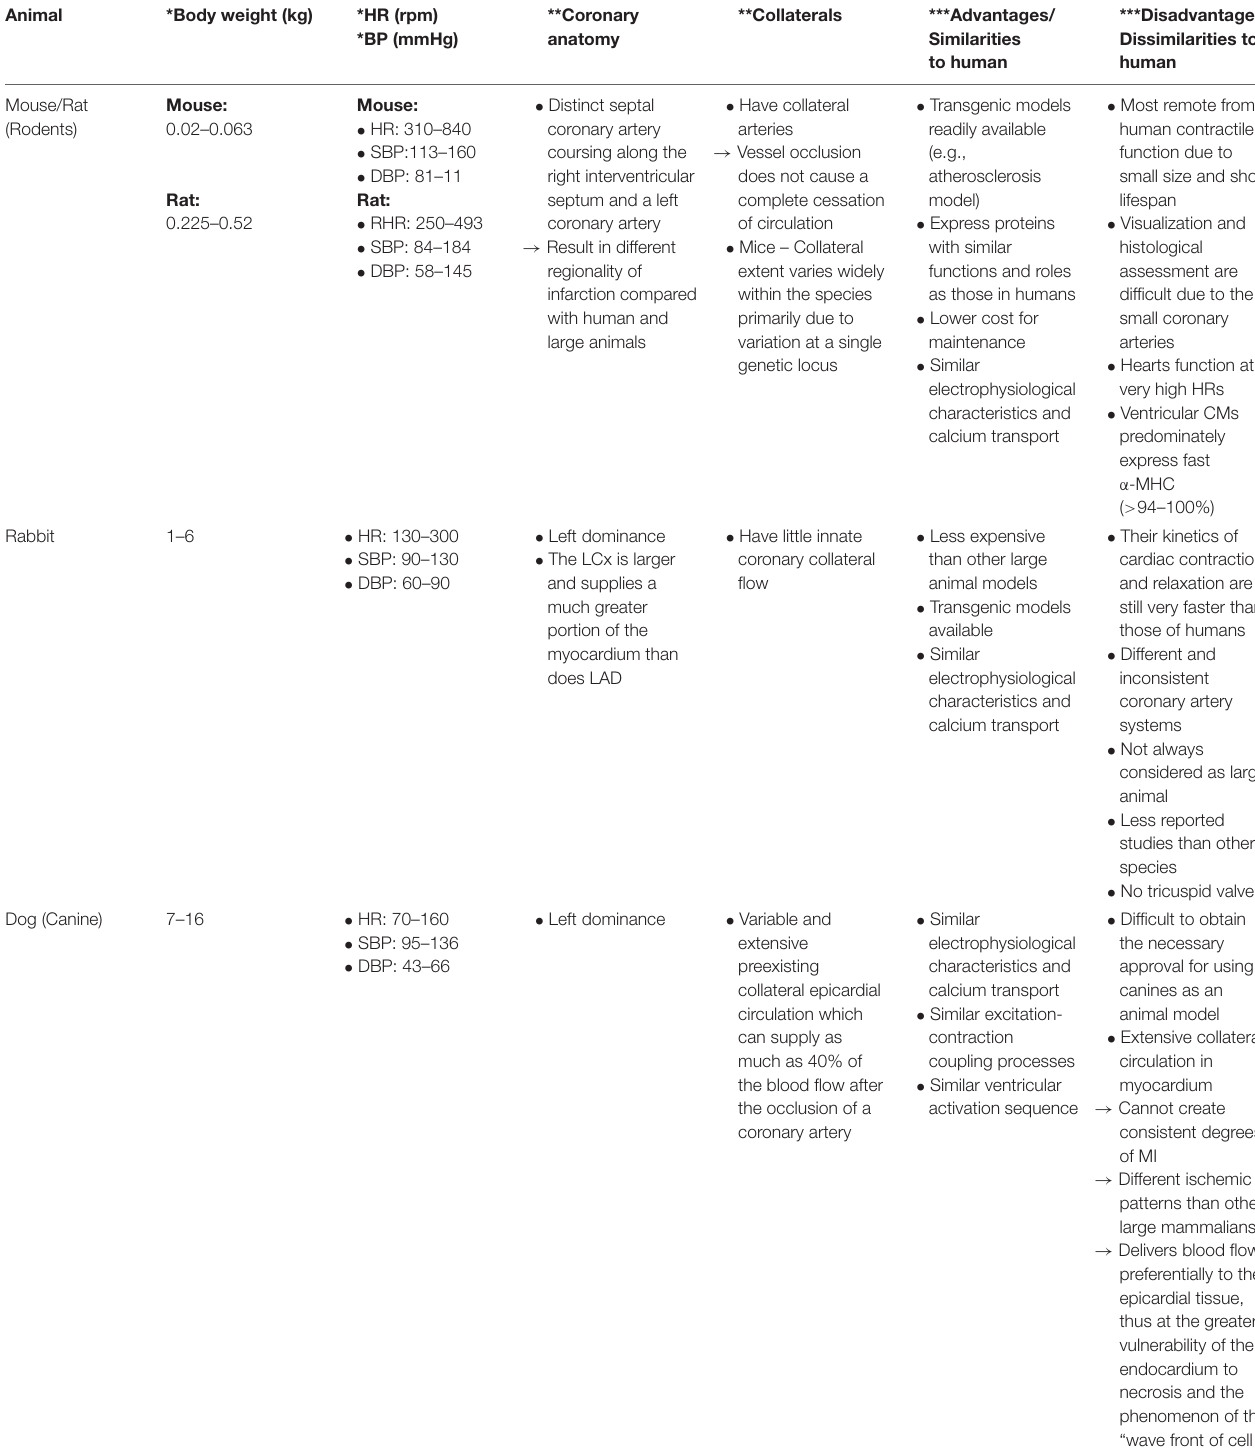
TABLE 1 | Comparison of central cardiovascular systems in small and large animals used in MI study.